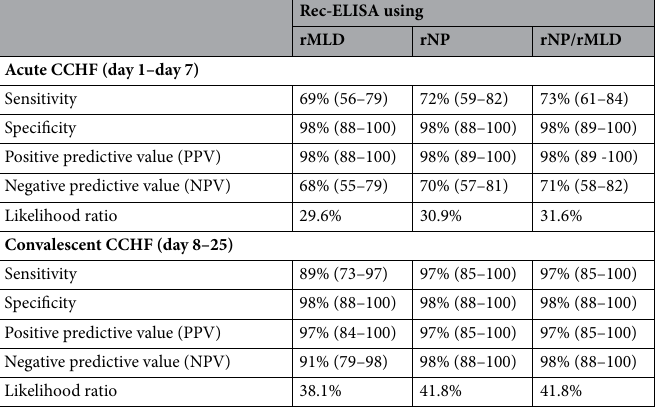
Table 3. The efficacy of Rec-ELISA using rNP, rMLD, and rNP/rMLD for the detection of anti -CCHFV IgG antibodies in sera of acute and convalescent CCHF patients Except for Likelihood ratio, data presented as percent (95% confidence Interval).